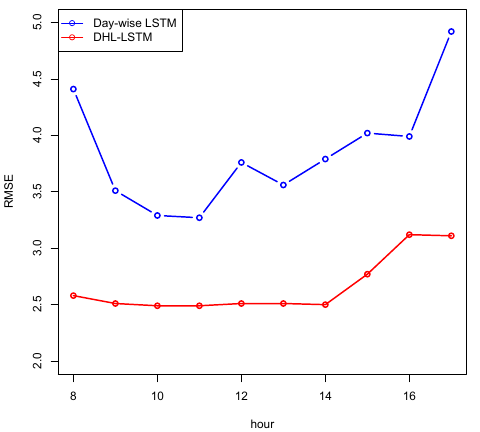
Figure 9. Variations of average RMSEs of temperature prediction for image sequences captured in different daytime